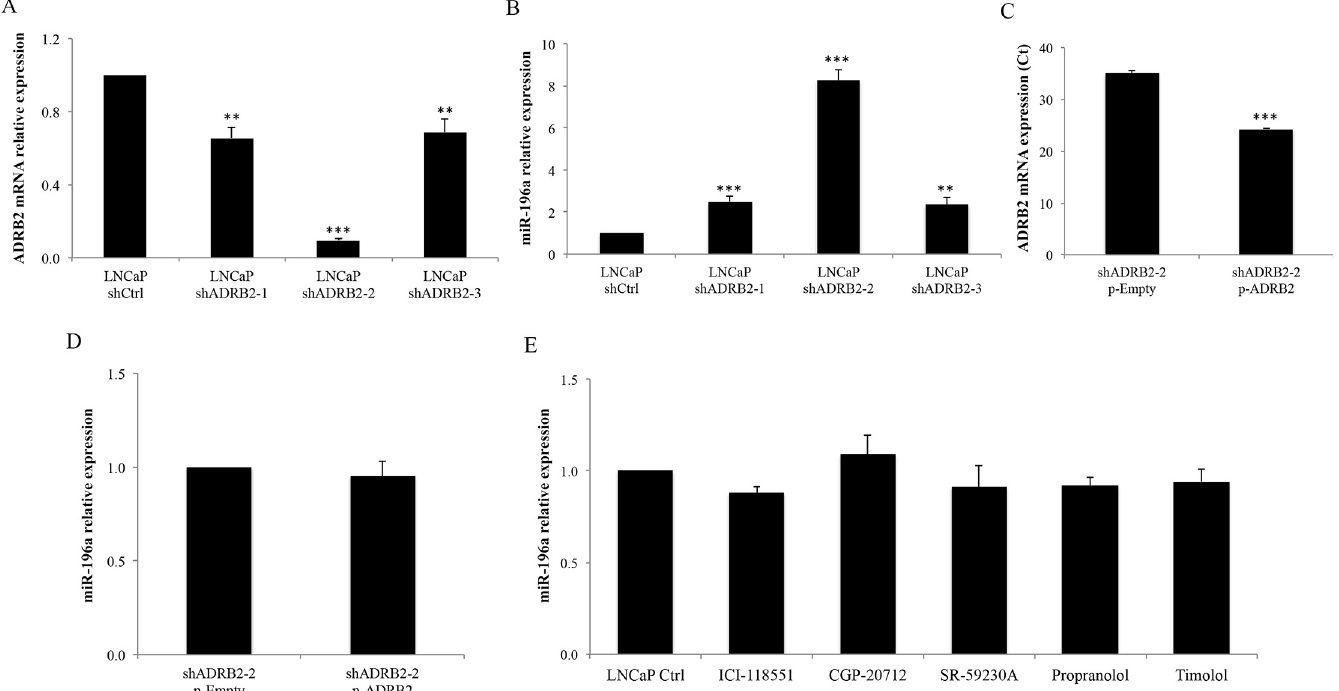
Fig 1. miR-196a expression in LNCaP cells with altered levels or signaling of ADRB2. (A) qRT-PCR analysis of ADRB2 in stably transfected LNCaP cells, shADRB2- 1, shADRB2-2 and shADRB2-3, and negative control cells, shCtrl. A representative experiment with triplicates is shown. (B) qRT-PCR analysis of miR-196a in stably transfected LNCaP cells, shADRB2-1, shADRB2-2 and shADRB2-3, and negative control cells, shCtrl. (C) qRT-PCR analysis of ADRB2 in shADRB2-2 cells transfected with a plasmid overexpressing ADRB2 (shADRB2-2 p-ADRB2) and negative control cells (shADRB2-2 p-Empty). (D) qRT-PCR analysis of miR-196a in shADRB2-2 cells transfected with a plasmid overexpressing ADRB2 (shADRB2-2 p-ADRB2) and negative control cells (shADRB2-2 p-Empty). (E) qRT-PCR analysis of miR-196a in LNCaP Ctrl cells treated with different β -blockers or vehicle for 48 hours. The experiments were performed three times and a representative experiment showing the mean ± standard deviation of three replicates is presented in the figure. miR-196a expression was normalized to the reference gene miR-16-5p. The ADRB2 mRNA levels were normalized to the reference gene ALAS1.